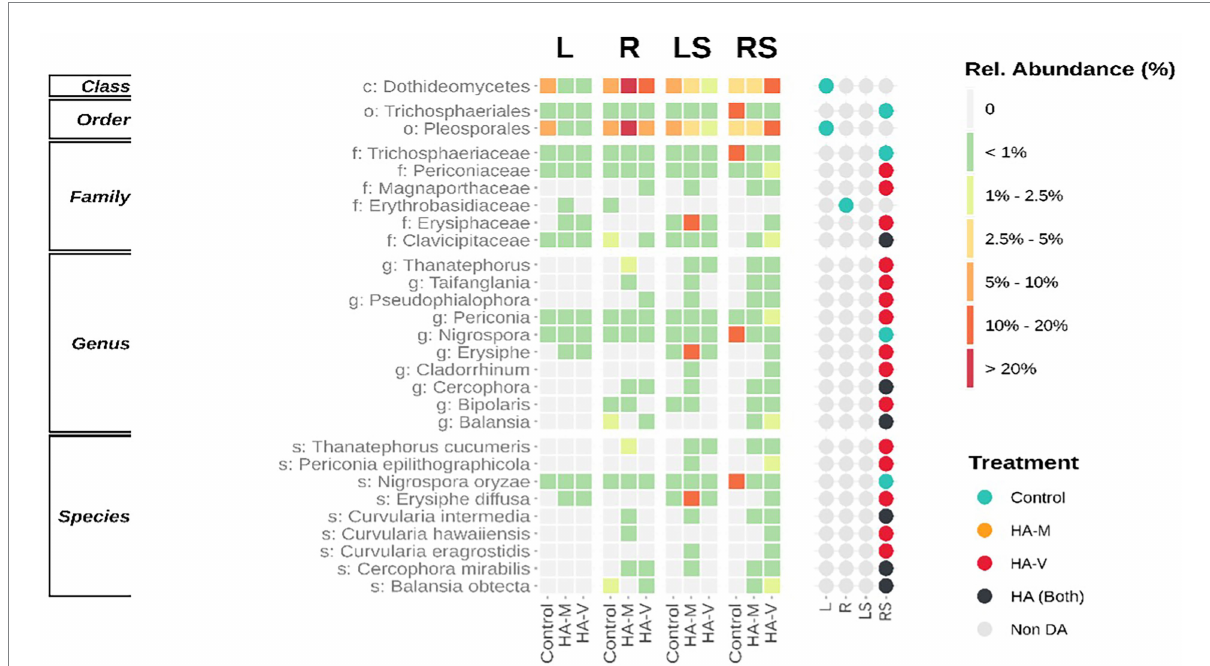
FIGURE 5 Different abundant (DA) fungal taxa. Both levels are presented ordered by the sum of relative abundances. The heatmap (left) demonstrates the relative abundance of taxa in leaves (L), roots (R), stressed leaves (LS), stressed roots (RS) by applying millicompost humic acid (HA-M), vermicompost humic acid (HA-V) and without application of HA (control). The dot plot (right) reveals in which niche differences in abundance between plant materials